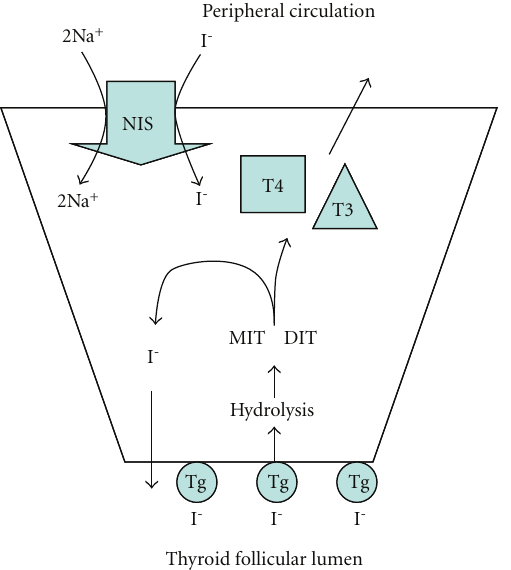
Figure 1: Thyroid hormone synthesis. NIS: Sodium-iodide sym- porter; T4: Thyroxine; T3: Triiodothyronine; MIT: Monoiodothy- ronine; DIT: Diiodothyronine; Tg: Thyroglobulin (I − :